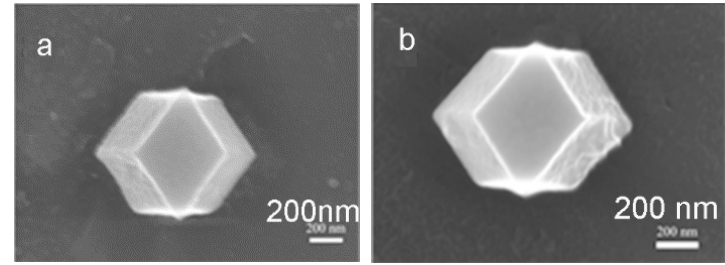
Figure 3. X-ray diffraction (XRD) patterns of ZIF-67 and ZIF-67-IL.